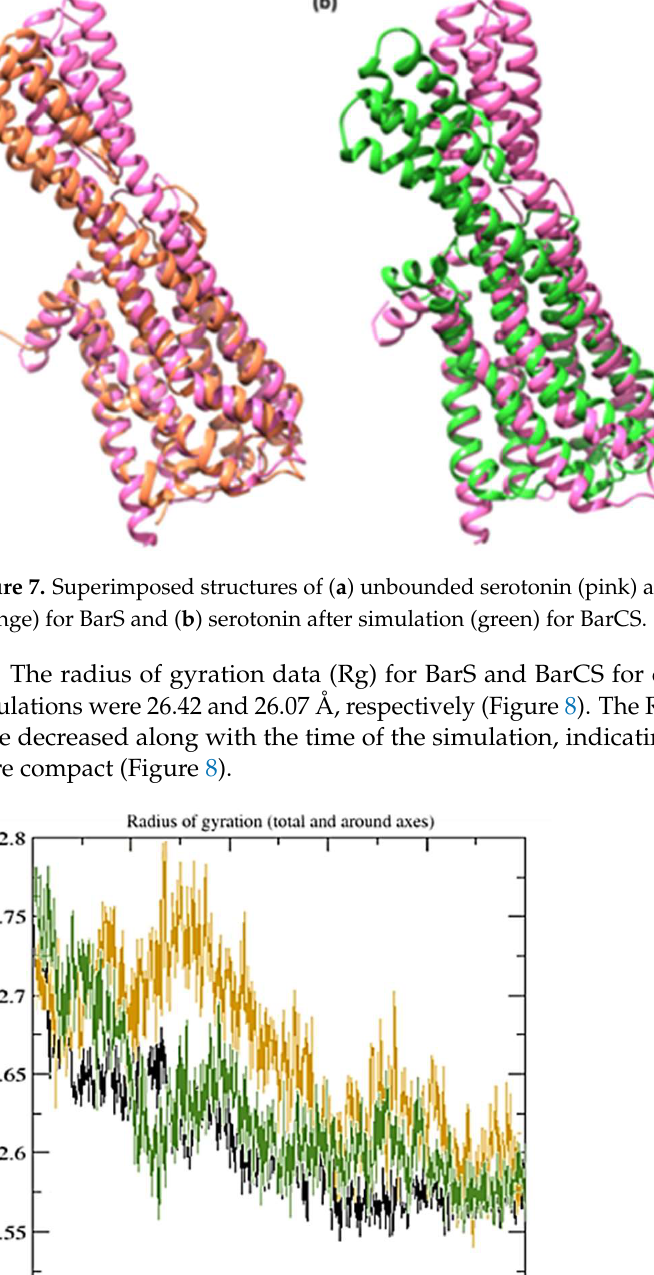
Figure 6. The RMSD over 100 ns. The black color represents serotonin receptor alone, orange color represents the BarS complex, and green color represents the BarCS complex.